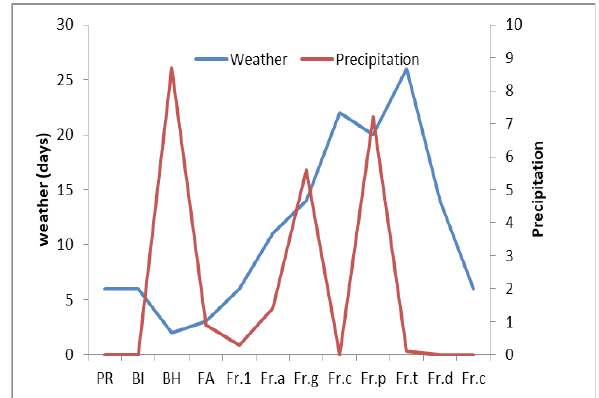
Figure 7. Fluctuations of subtle lemon ( Citrus aurantifo- lia Swingle) from primordium to fruit harvested as a func- tion of precipitation.